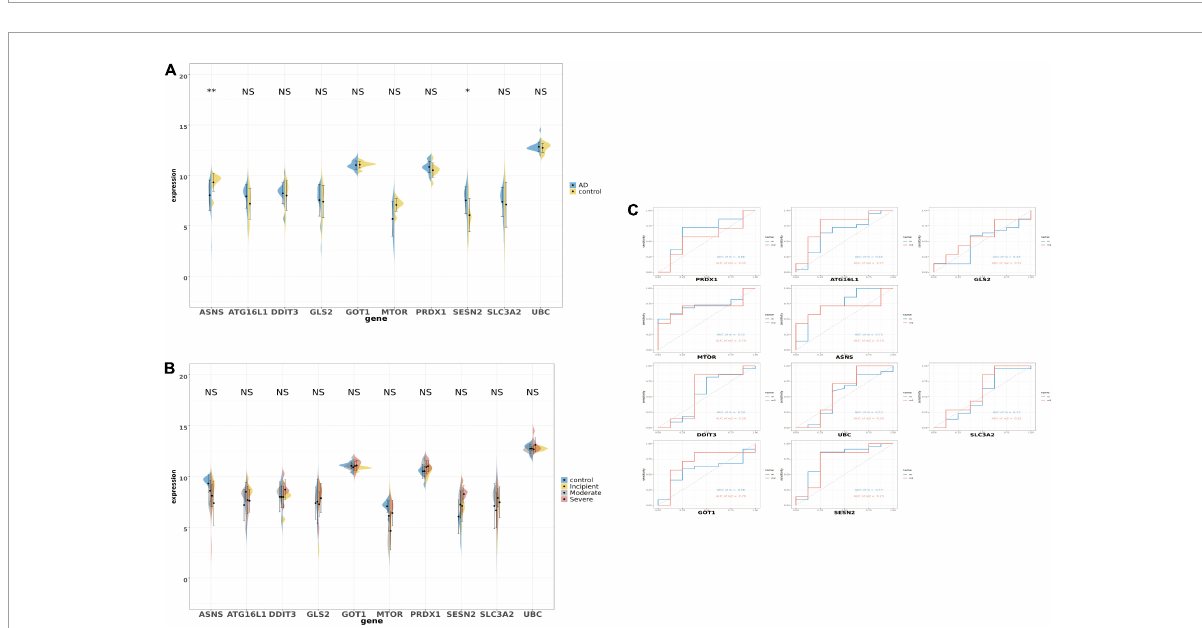
FIGURE5 The boxplot and violine plot of the expression in the top 10 ranked ferroptosis-related DEGs, aimed at finding the significance and the receiver operator characteristic (ROC) curve in order to illustrate the diagnostic value of ferroptosis-related DEGs by monofactor analysis. (A) The expression of the 10 ferroptosis-related genes in AD compared with the non-AD group within the hippocampus region in GSE28146. (B) The expression of the 10 ferroptosis-related genes in AD compared with the non-AD group within the hippocampus region in the different stages of dementia in GSE28146. (C) AUC in the top 10 ranked ferroptosis-related genes in the ROC curves in GSE28146. * p < 0.05; ** p < 0.01; NS, not significant, p ≥ 0.05, non-AD control vs. AD; m2, control vs. incipient vs. moderate vs.